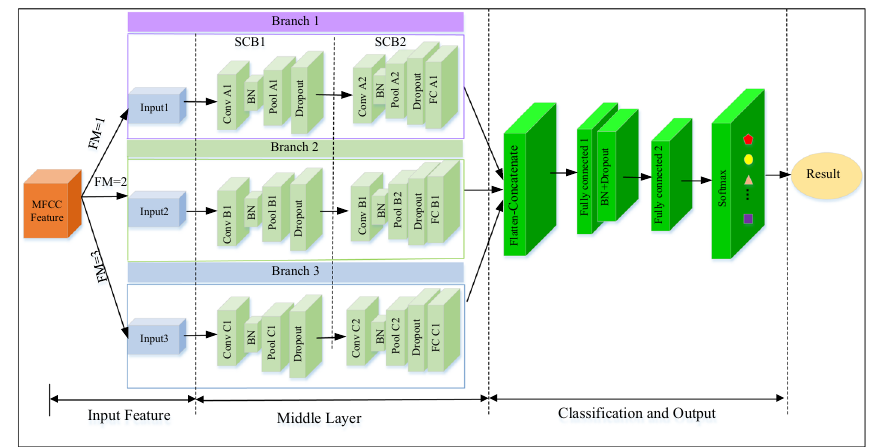
Figure 3. Proposed MBCNN framework for coal-gangue recognition using MFCC